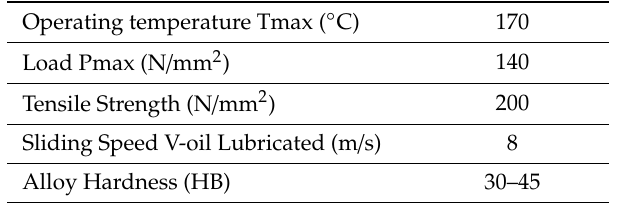
Table 2. Mechanical properties of SAE-48 bearing alloy (CuPb30).